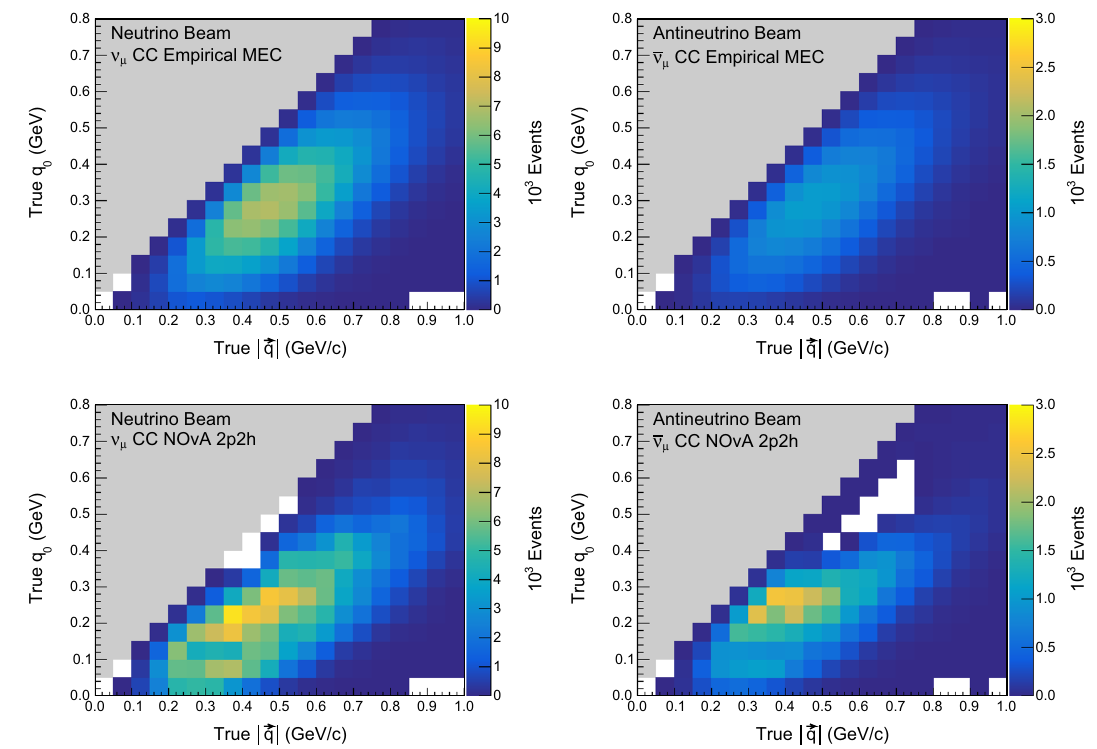
Fig. 5 Predicted momentum and energy transfer distributions for unmodified Empirical MEC (top row) and the result of applying the weights shown in Fig. 4 to Empirical MEC to obtain NOvA 2p2h (bottom row), for neutrino beam (left) and antineutrino beam (right).